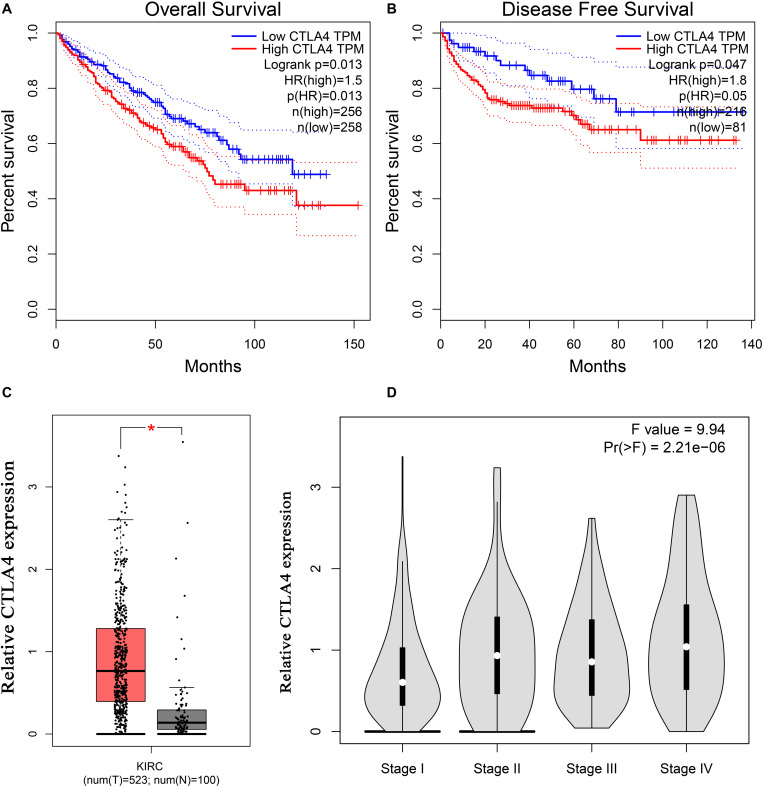
Validation of CTLA4. Kaplan–Meier survival curve based on the GEPIA database revealed that ccRCC patients with a higher expression of CTLA4 had a significantly shorter (A) overall survival time and (B) disease-free survival time. (C) Expressions of CTLA4 in ccRCC were significantly higher than those in normal tissues based on the TCGA-KIRC database (*P < 0.05). (D) High expression of CLTA4 related to higher tumor stage.